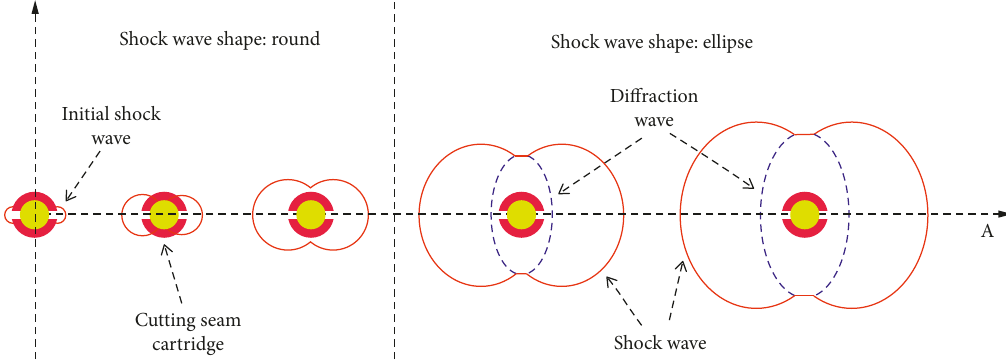
Figure 6: Physical model of explosive wave in cutting seam cartridge.